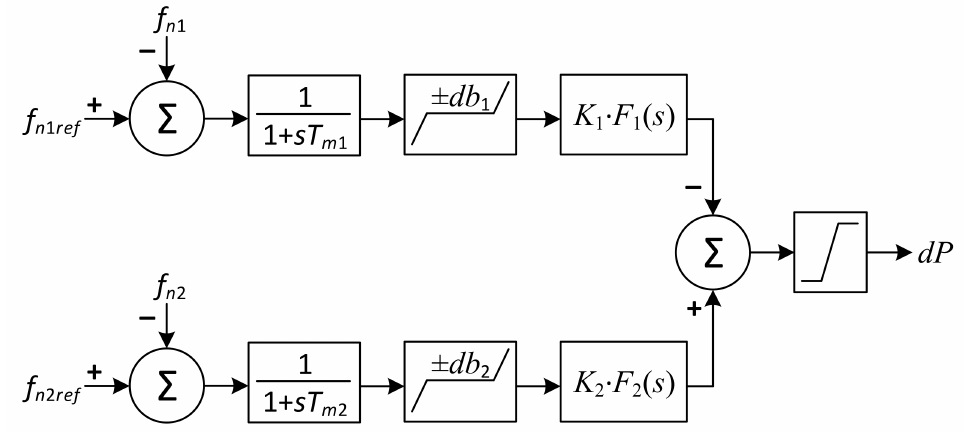
Figure 3. Structure of a frequency